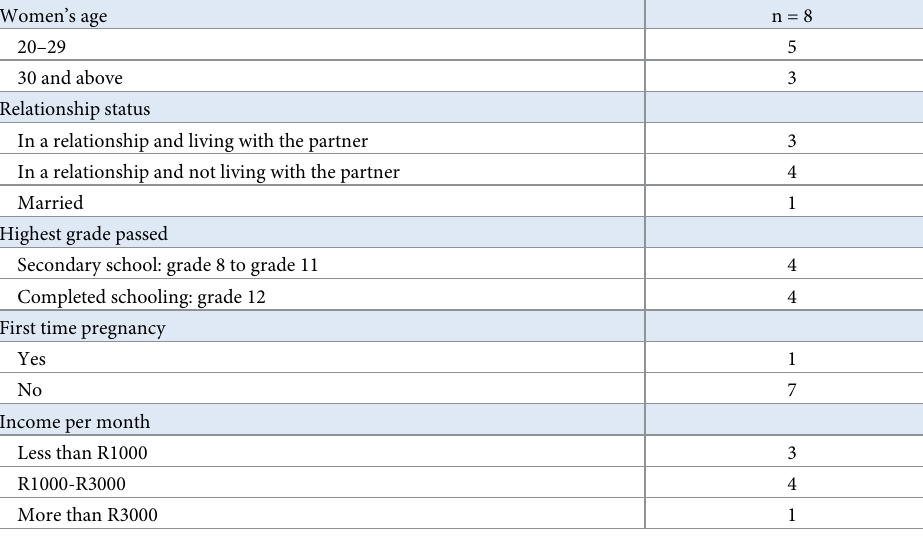
Table 1. Demographic characteristics of